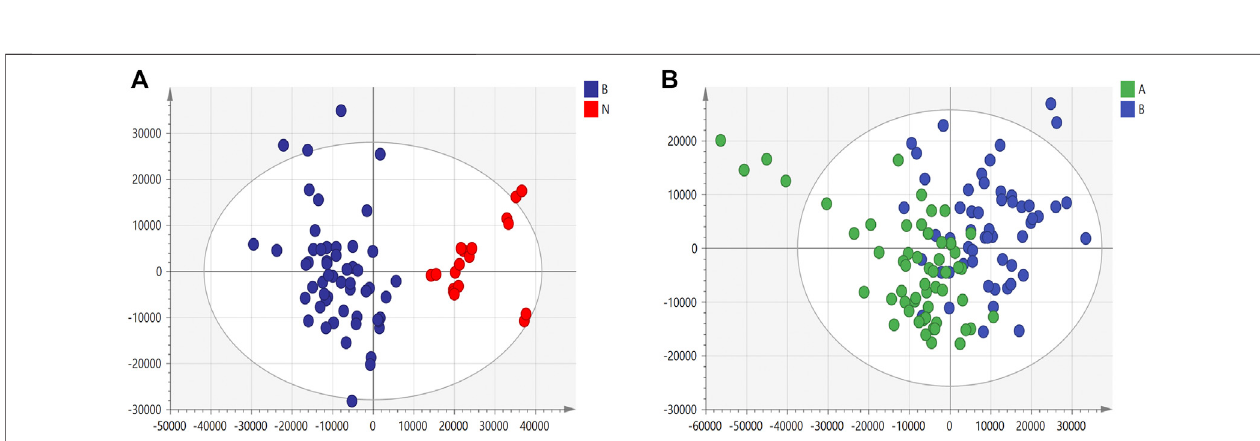
FIGURE5| ThePCAscoreplotsunderpositiveionmode. (A) HealthycontrolgroupandOraldiseasegroup (B) OraldiseasegroupandHLJDDinterventiongroup. Red dot represents the healthy control group, blue dot represents the oral disease group, green dot represents the HLJDD intervention group.